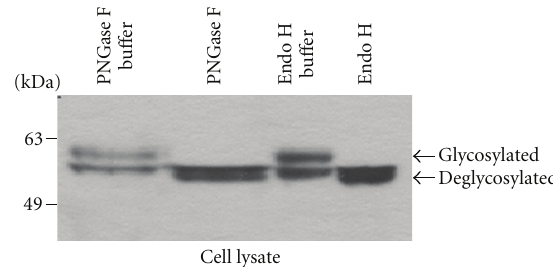
Figure 3: Deglycosylation of MMP-28 examined by Western blotting. The cell lysate of COS-1 cells transfected with MMP-28 along with furin cDNAs was treated with and without PNGase F or Endo H. The samples were then examined by Western blotting using anti-Myc